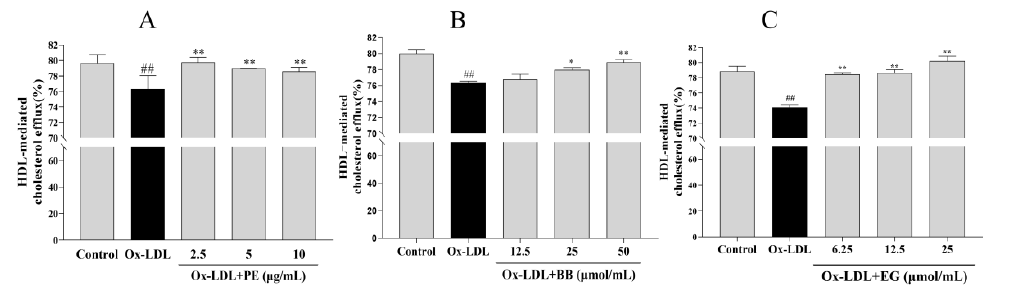
Figure 4. The effect of PE ( A ), BB ( B ), and EG ( C ) on cholesterol efflux mediated by HDL. # p < 0.05, ## p < 0.01 vs. normal control; * p < 0.05, ** p < 0.01 vs. ox-DL-induced group.